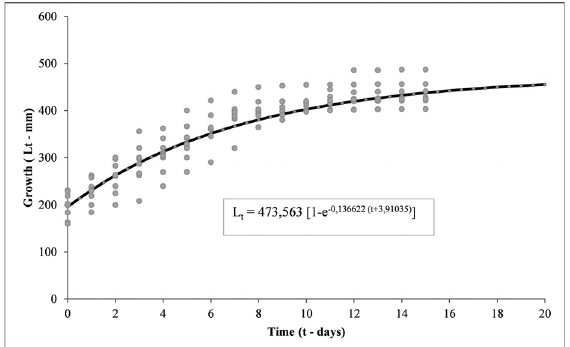
Figure 1 - Growth curve for individual Philodina roseola cultured at 25 ± 1°C and fed on the chlorophycean microalga Raphidocelis subcapitata at a density of 1x10 5 cells mL -1 . The data points show the observed values for 9 replicate